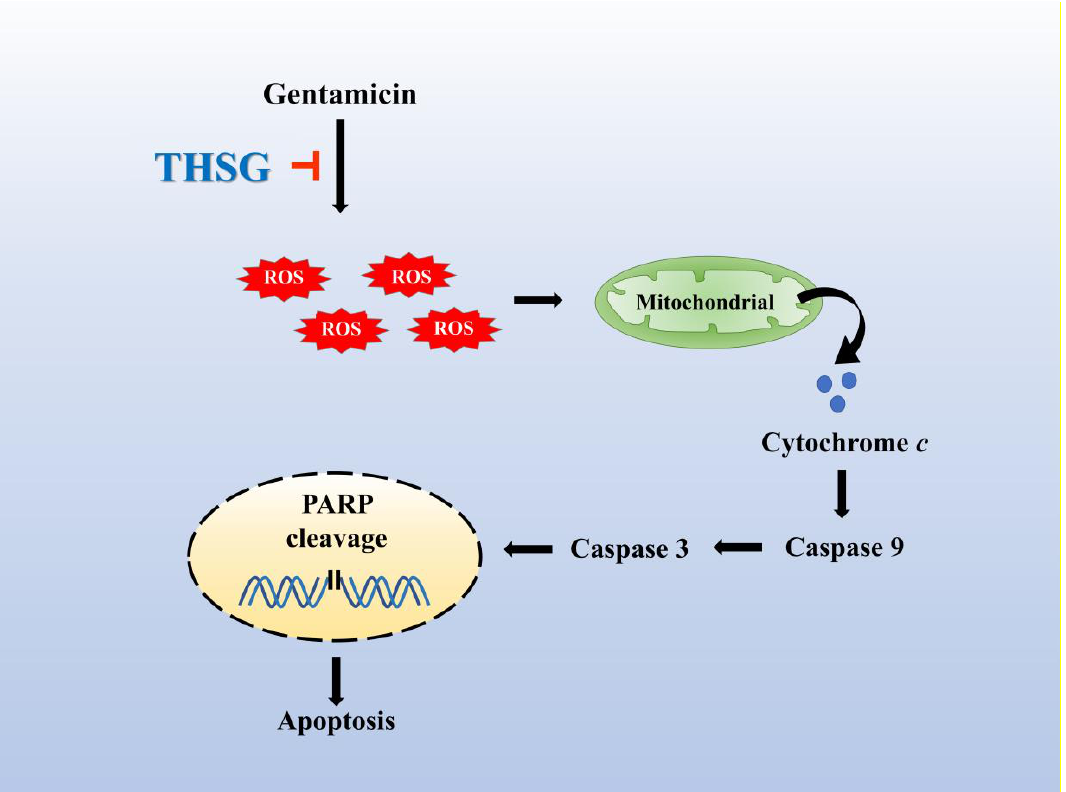
Figure 6. The otoprotective mechanism of THSG in alleviating gentamicin-induced UB/OC-2 cell apoptosis. THSG treatment impairs gentamicin-induced apoptosis by reducing ROS production, stabilizing mitochondrial membrane potential, and downregulating mitochondrial-dependent apoptotic protein expression.